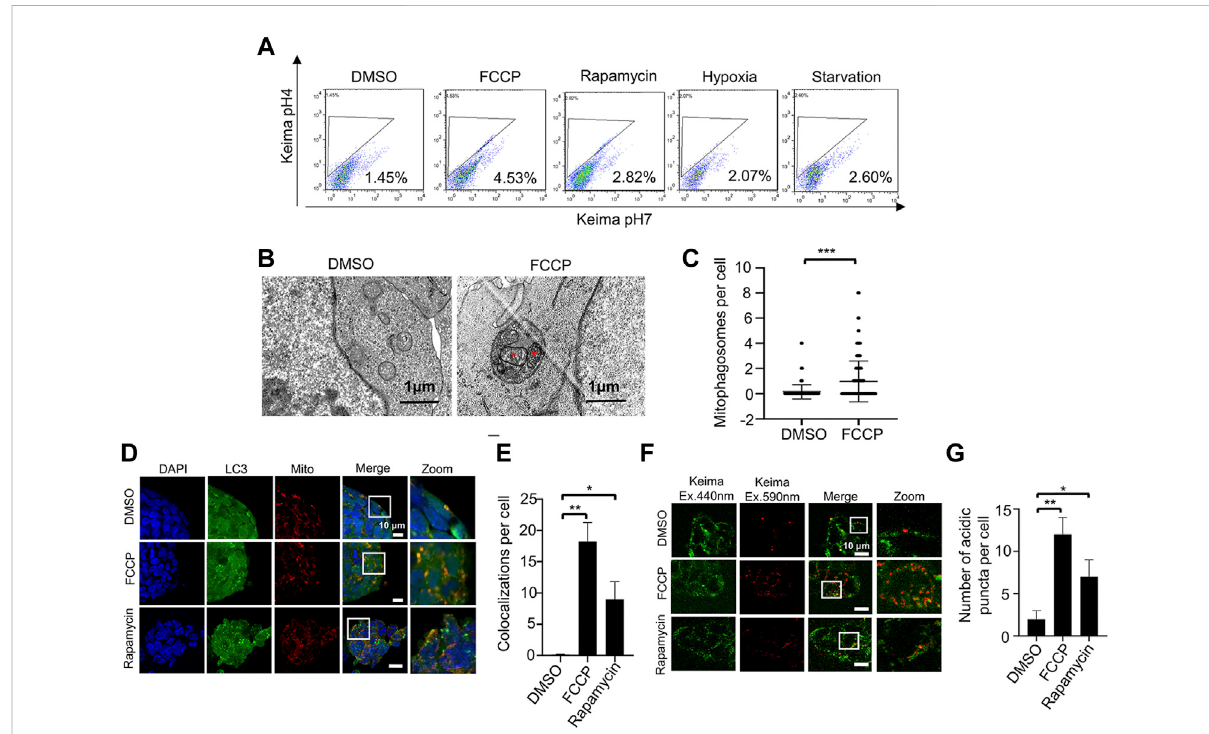
FIGURE 2 Two fl uorescence-based imaging systems for measuring mitophagy in ESCs under mitochondrial stress. (A) , Mitophagy activation in ESCs is evaluated by mt-Keima system using a FACS. ESCs stably expressing mt-Keima were treated with FCCP, rapamycin, hypoxia or starvation, and then analyzed by a FACS. Data shown is one of three independent experiments. (B) , FCCP triggers mitophagy in ESCs. ESCs were treated without or with 10 nMFCCP,thensampleswereharvestedforexaminationbytransmissionelectronicmicroscopy.Theredasterisksindicatetwomitochondria enclosed within an autophagosome. (C) , Quanti fi cations of mitophagosomes in (B) . Mitophagosomes were counted in 200 cells. Data are shown as mean±SD, n =200;*** p < 0.001,Student ’ st-test. (D) ,TheEGFP-LC3systemformonitoringmitophagy.ByusingMito-RFP,EGFP-LC3ESCs,wecan observe co-localizations of LC3 and mitochondria. After FCCP or rapamycin treatment, co-localizations of LC3 and mitochondria are increased. Green: LC3; red: mitochondria; blue: DAPI. (E) , Quanti fi cation of mitophagy in ESCs by the EGFP-LC3 system. Co-localizations of LC3 and mitochondriawerecountedin200cellsfrom3independentexperiments.Dataareshownasmean±SD, n =3;* p < 0.05,** p < 0.01,Student ’ st-test. (F) , The mt-Keima system for monitoring mitophagy. By transfecting mt-Keima into ESCs, we can observe the mitochondrial network (green signal) andmitochondriawithinacidicautolysosomes(redpuncta).AfteraddingFCCPorrapamycin,thenumberofredpunctaincreases. (G) ,Quanti fi cation of mitophagy in ESCs by the mt-Keima system. Red puncta were counted in 200 cells from 3 independent experiments. Data are shown as mean